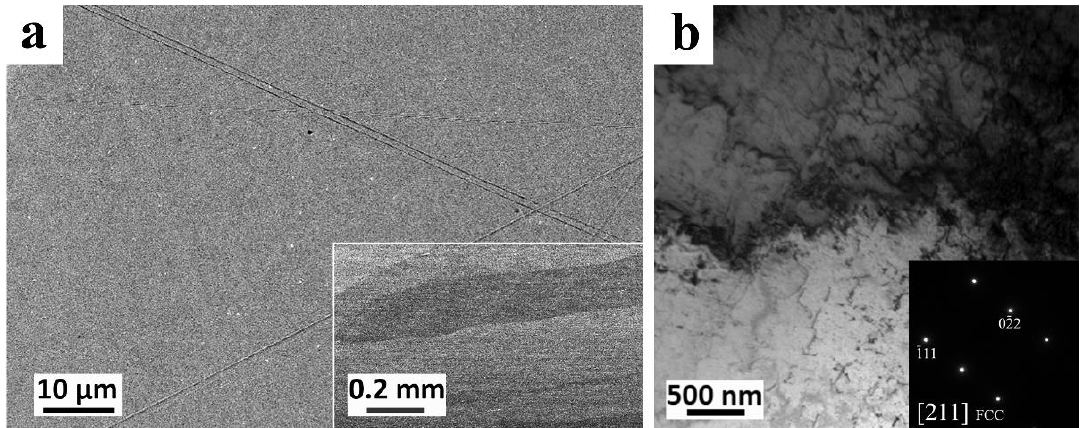
Figure 2. Microstructure of the CoCrFeNi (w/o Al) alloy. ( a ) SEM general view image. Low magnification image is shown in the inset. ( b ) Typical bright field (BF) TEM image showing high dislocation density. Selected area electron diffraction (SAED) pattern taken from a grain of the CoCrFeNi (w/o Al) alloy at [211] orientation is shown in the inset.